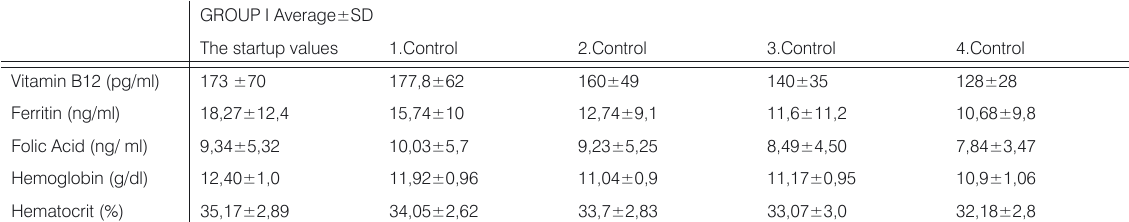
Table 2. Blood Analysis Values of Group